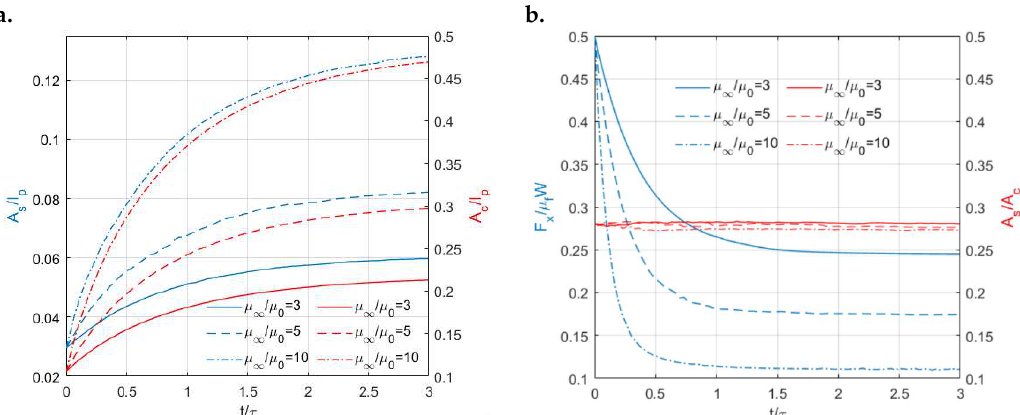
Figure 20. Solutions to the stick–slip contact of different viscoelastic materials (Zener model) under constant displacement in x direction: ( a ) Variations in the ratio of the stick region to the simulation domain ( y axis left) and the ratio of the contacting area to the simulation domain ( y axis right) with time and ( b ) Variations in the resulting tangential loads ( y axis left) and stick ratios ( y axis right) with time for different viscoelastic materials (Zener model).